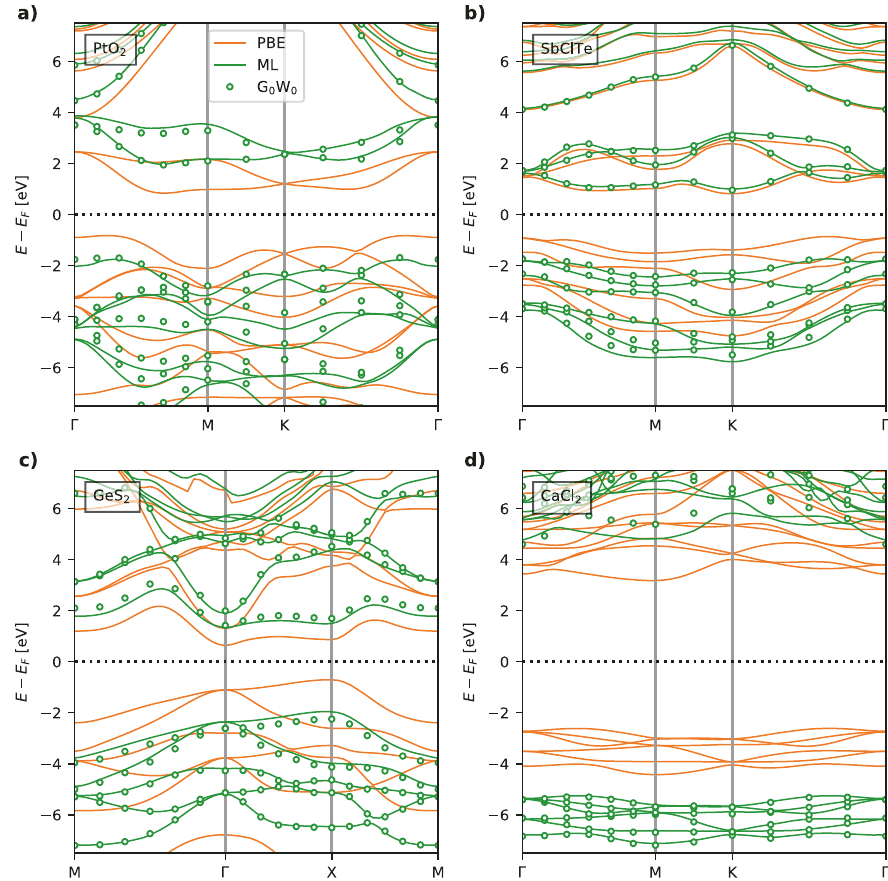
Fig. 5 Machine-learned band structures. Examples of band structures for four 2D materials from the test set. Both PBE and GW band structures are shown along with the ML predictions. The materials are selected to cover a wide range in the prediction accuracy of the test set. Band structures for PtO 2 ( a ), SbClTe ( b ), GeS 2 ( c ), and CaCl 2 ( d